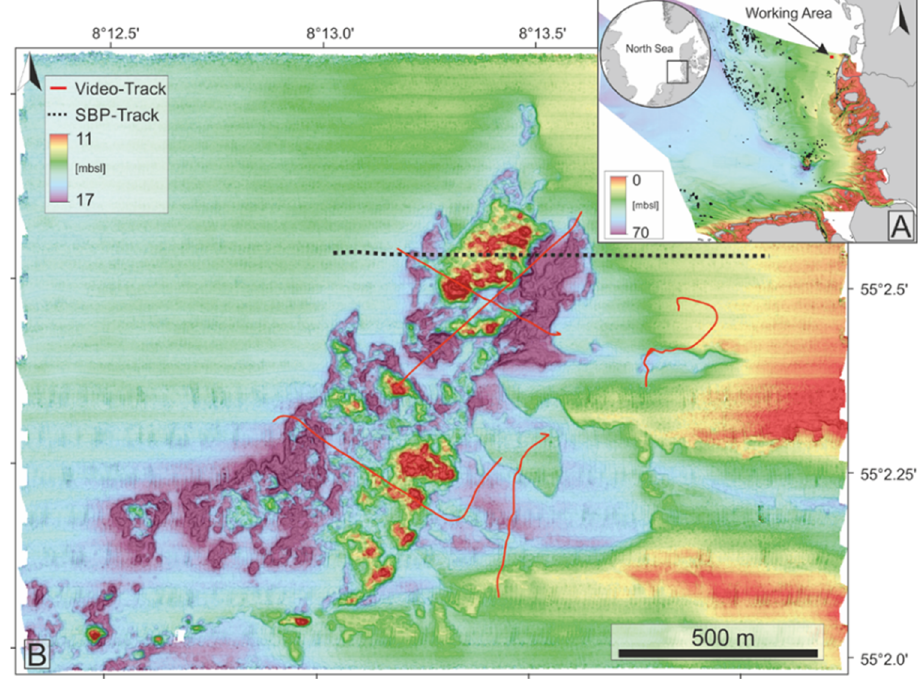
Figure 1. ( A ): Bathymetry of the German North Sea (adapted with permission from [25]) with gravelly and stony areas in black after Figge [3] and the location of the working area (in red). ( B ): Bathymetric overview of the study area ~10 km offshore the island of